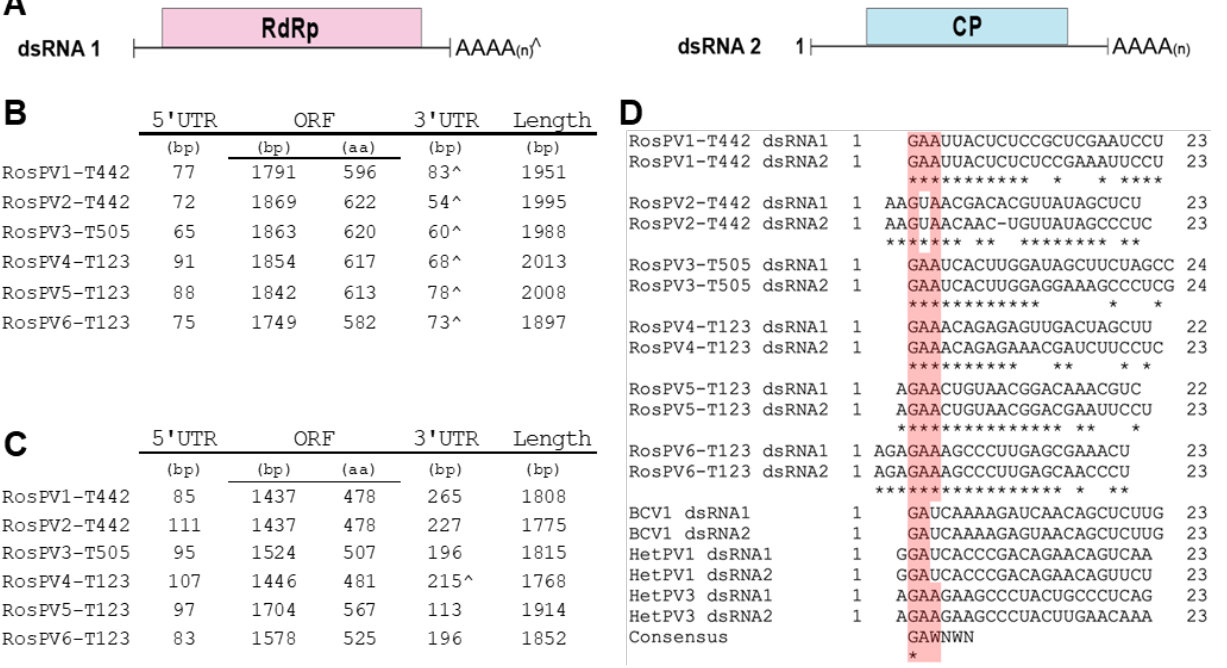
Figure 2. Schematic representation of the genomic composition of the six partitiviruses discovered from three R. oryzae-sativae isolates. ( A ) Genomic organization of the two dsRNAs that constitute a single partitivirus. The red and blue rectangular boxes represent open reading frames (ORFs) in each segment encoding RdRp and CP. ( B , C ) The genomic composition of the dsRNA1 and dsRNA2 of each partitivirus are described in B, and C, respectively. ^ indicates interrupted poly(A) tails at 3 ′ UTR. ( D ) A portion of 5 ′ UTR sequences was aligned with previously-characterized alphapartitiviruses showing conserved residues at the terminal regions. The pink-highlighted box illustrates the conserved residues in the aligned sequences. Consensus was obtained from [22] to further support the conservation of the plus strand terminal regions of alphapartitiviruses.